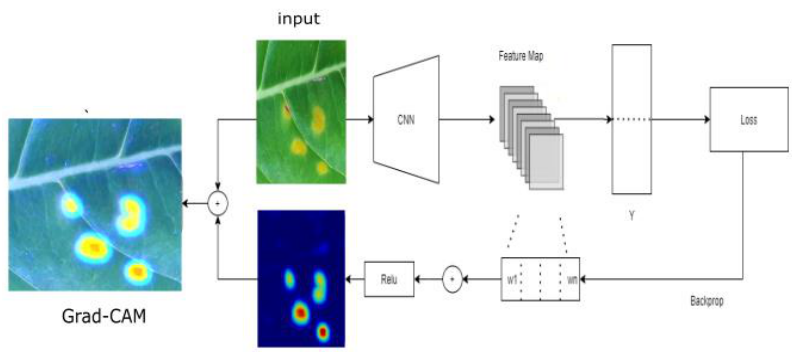
Figure 1. Block diagram of Grad-Cam on coffee disease